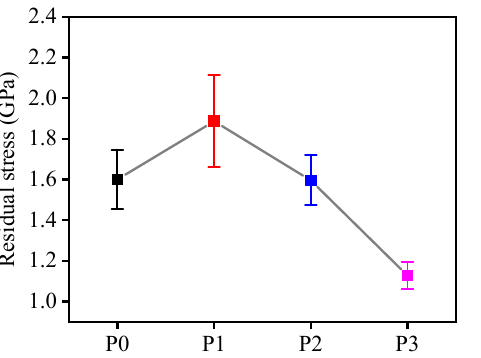
Figure 16. Relationship between residual stress on the coating surface and ultrasonic vibration power.